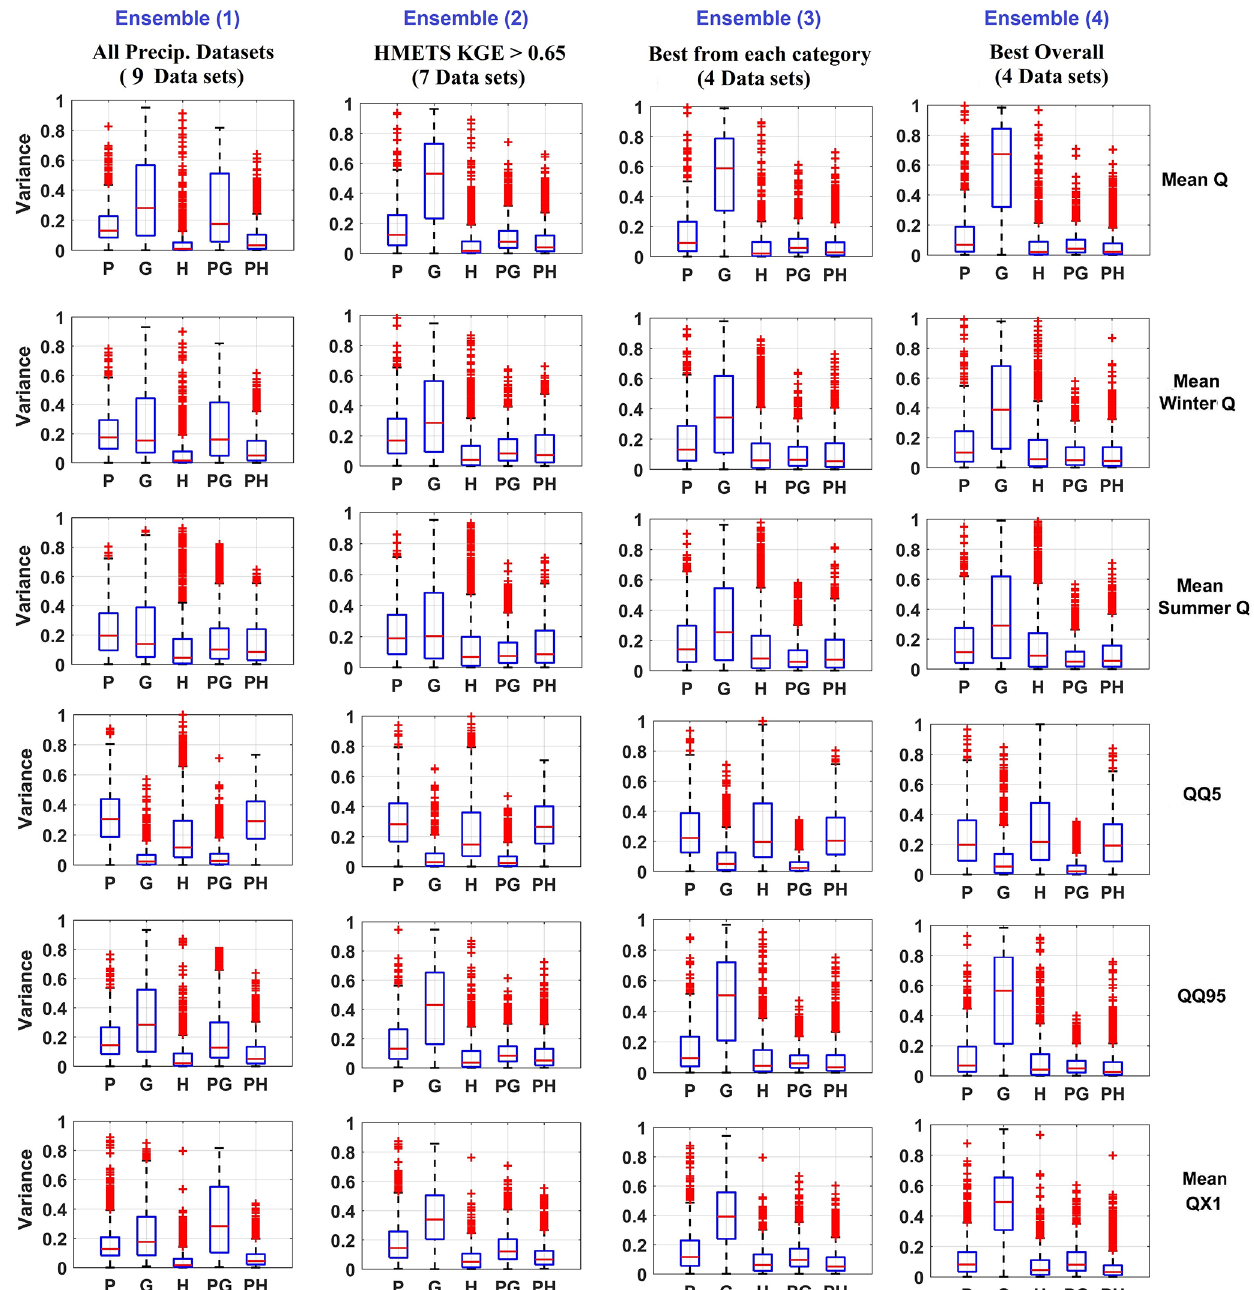
Figure 7. Box plots of the five main components of the variance attribution, including precipitation (P), GCMs (G), hydrological models (H), interaction between precipitation datasets and GCMs (PG) and interaction between precipitation datasets and hydrological models (PH). Columns represent the four precipitation ensembles of Table 4, while rows represent the six hydrological indices investigated in this